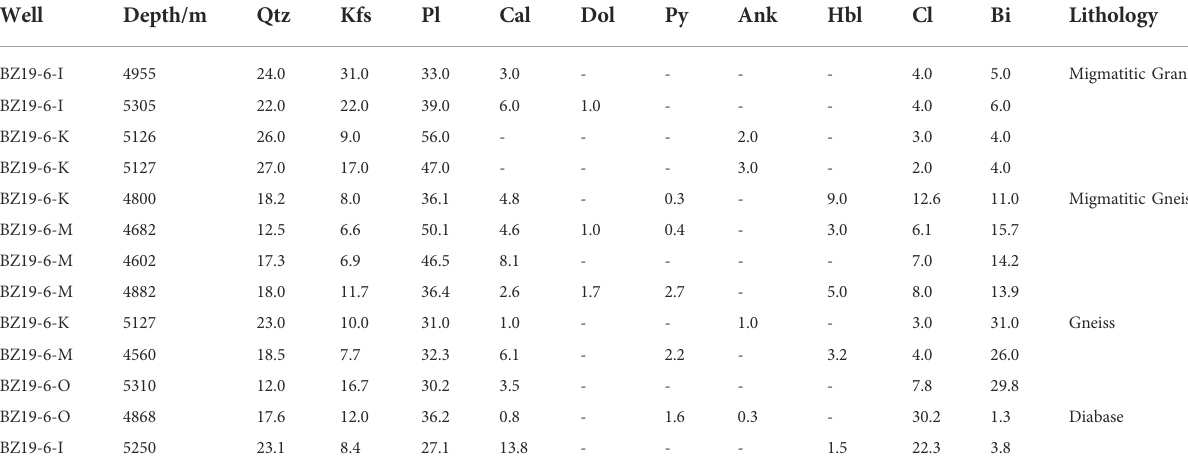
TABLE 1 X-ray diffraction (XRD) analyses showing the whole-rock mineralogy of intrusions and metamorphic rocks from the Bozhong sag (weight Percent, %).